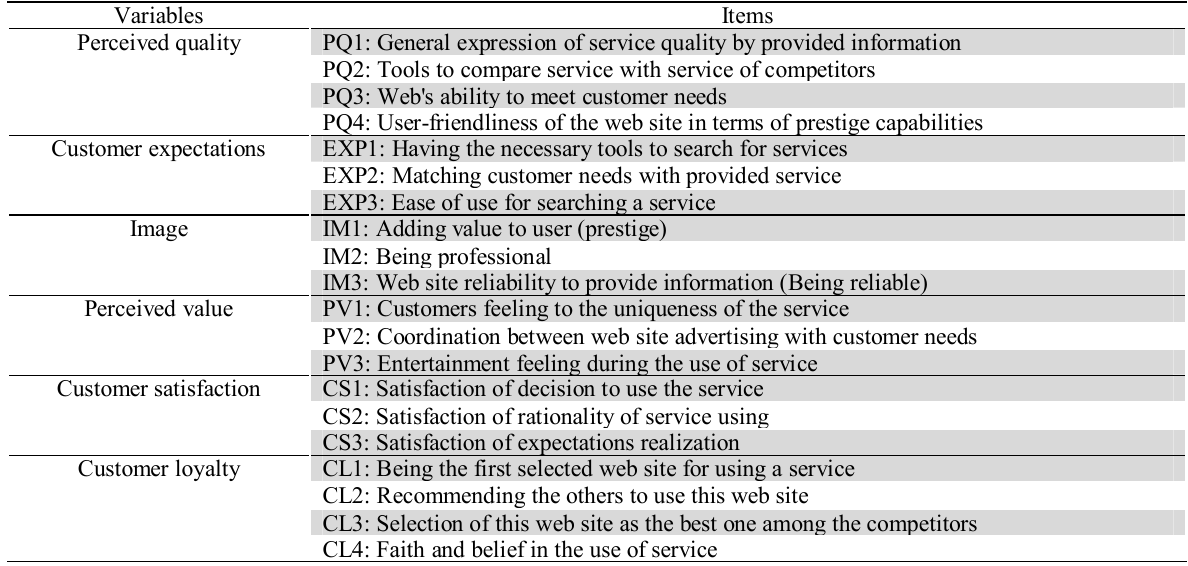
Constituent variables and items related to the model of customer satisfaction